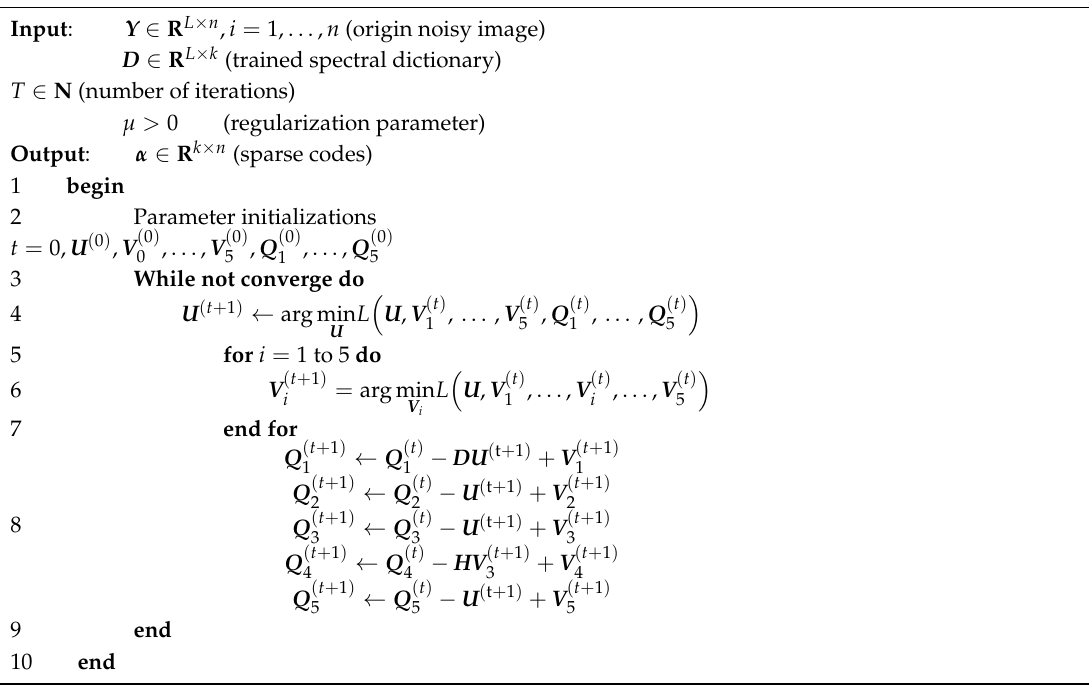
Algorithm 2 Sparse regression by variable splitting and augmented Lagrangian and total variation (SpaRSAL-TV).